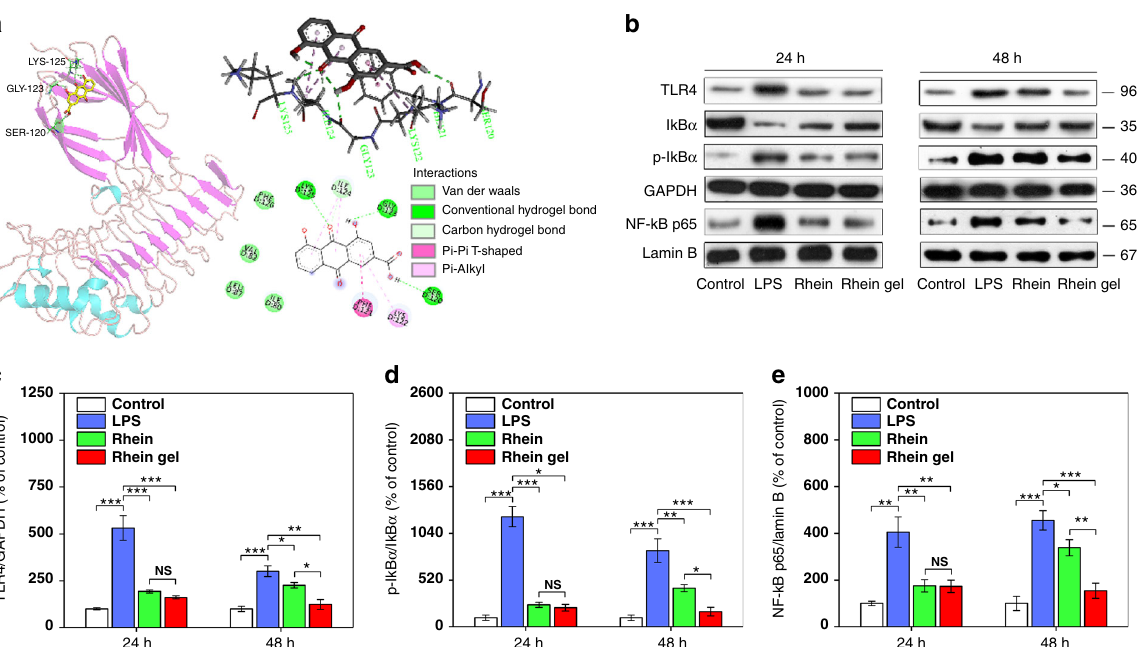
Fig. 6 Rhein and rhein hydrogel inhibited TLR4/NF κ B pathway in LPS-induced BV2 cells. a Molecular docking analysis of the interaction between rhein and TLR4. Molecular docking model illustrated the interaction between rhein and the active sites of TLR4, showing the existences of intermolecular hydrogen bonds and π - π interactions. b Rhein and its hydrogel blocked the TLR4/NF κ B pathway, as shown by western blot analysis. Representative western blots of TLR4 in total proteins, I κ B α and p-I κ B α in cytosolic extracts, and p65 in nuclear extracts after treatment with rhein or rhein hydrogel for 24 and 48 h. The uncropped and unprocessed scans of blots are presented in Supplementary Fig. 13. c – e Quanti fi cation of TLR4 ( c ), p-I κ B α /I κ B α ( d ) and p65 ( e ) according to densitometric analysis. The results are presented as a ratio of TLR4/GAPDH, p-I κ B α /I κ B α and p65/Lamin B. Values are expressed as the means ± SEM ( n = 3). One-way ANOVA with Tukey ’ s post hoc test. * p < 0.05, ** p < 0.01, *** p < 0.001. Error bars represent of proin fl ammatory cytokines and neurotoxic fators 49 – 51 .